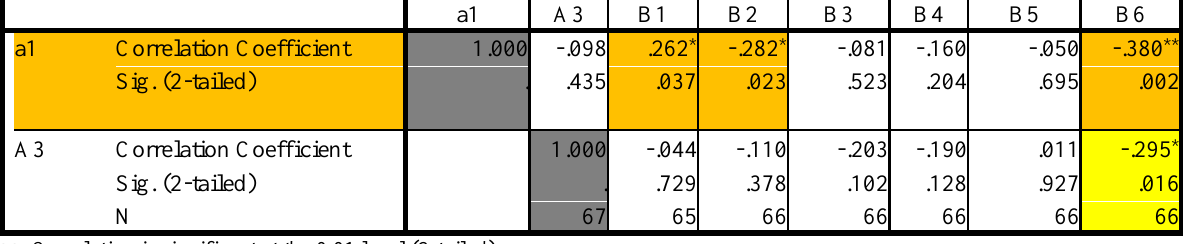
Table 3. Spearman Correlation between -Gender, time of Usage- and Public Place